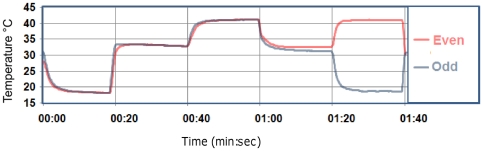
Temperature profiles of juxtapositioned silver bars during stimulation.Representative recordings from two adjacent silver bars (i.e. odd- and even- numbered) of the TGI-system. The recordings were made simultaneously using two infra-red thermosensors with a high temporal resolution. Each stimulus lasted 20-seconds. The graphs show an initial cold-stimulation (18.0±0.5°C), followed by a return to neutral baseline (31.0±2.0°C). This was followed by warm (41.0±0.5°C) and then baseline. Finally, the graphs show the TGI-condition (lasting from 01:20 to 01:40 mins) where adjacent bars have cold and warm temperatures, respectively.